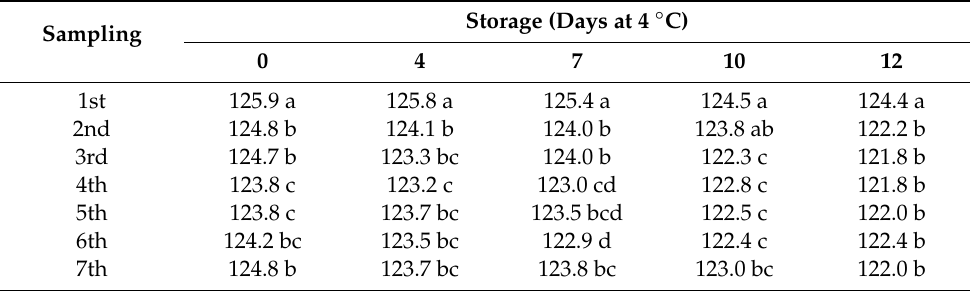
Table 6. Hue color parameter of baby rocket leaf during storage at 4 ◦ C for 12 days as a ff ected by growing season. Comparisons of the means were separately performed for each storage day. Means with di ff erent letters are significantly di ff erent ( a <